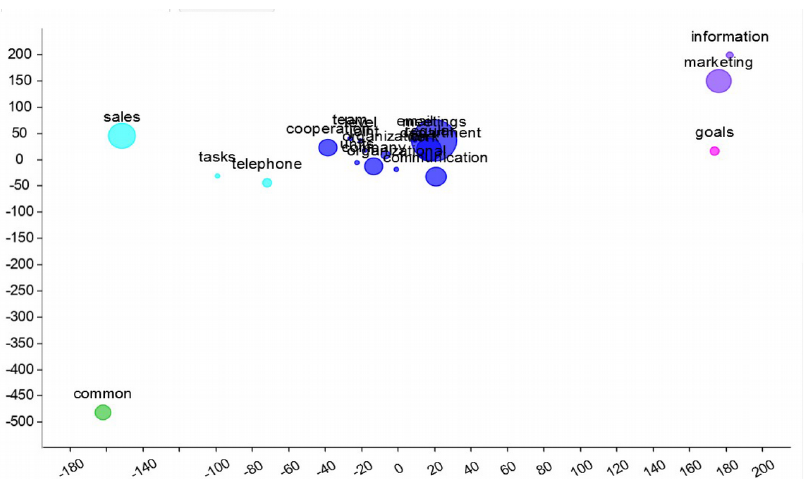
Figure 9. t-SNE generated clusters for the answers to Question 3, 100 iterations (Own editing using www.voyant.tools.org )